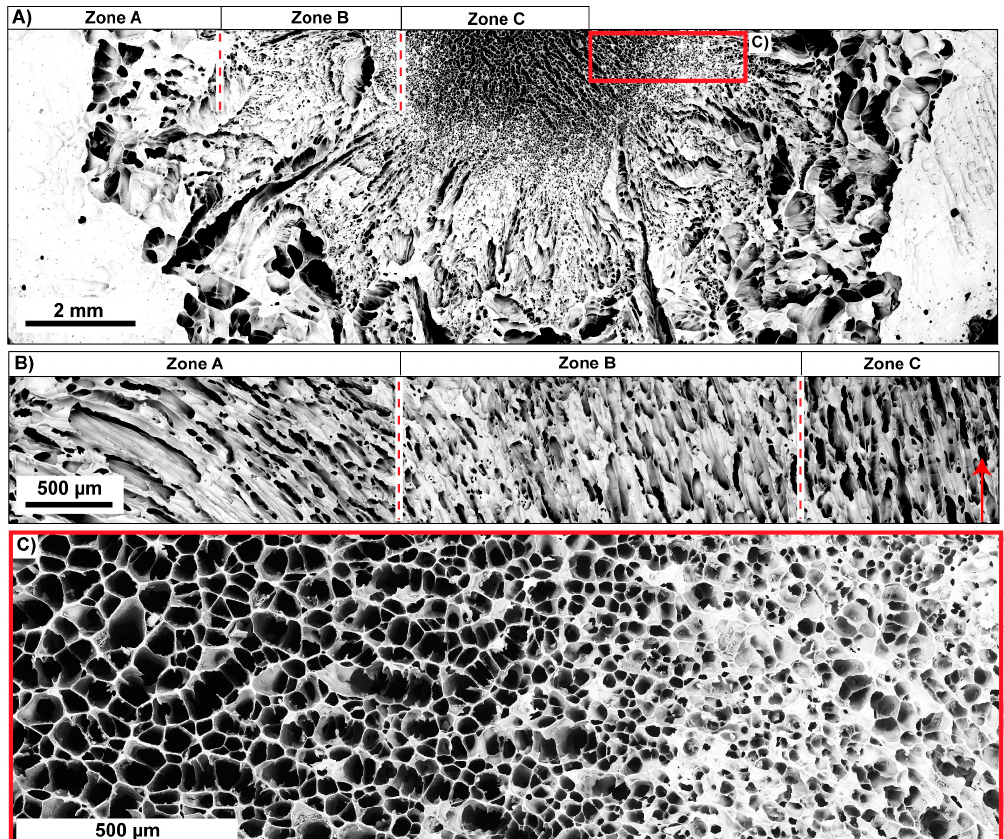
Figure 15. Structural graded ceramic inspired by the microstructure of Phyllacanthus imperialis . The microstructure of the ceramic and its division in different zones is displayed in ( A ) that illustrates the cross-sectional area perpendicular to the freezing direction. The orientation of the cell channels is given in ( B ). The red arrow demonstrates the freezing direction. A higher magnification of the graded structure is displayed in ( C ). The area is marked as red rectangle in ( A ).